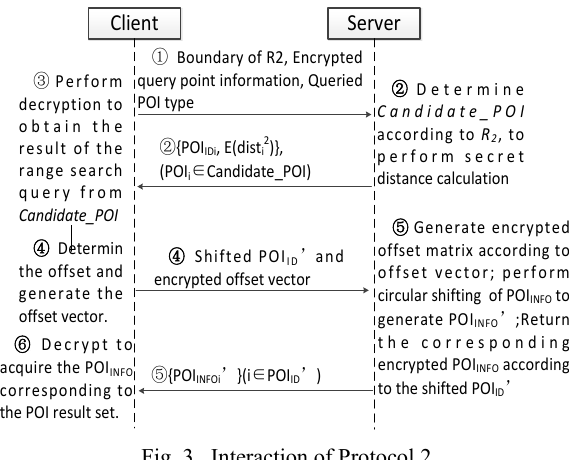
Fig. 2. Interaction of Protocol